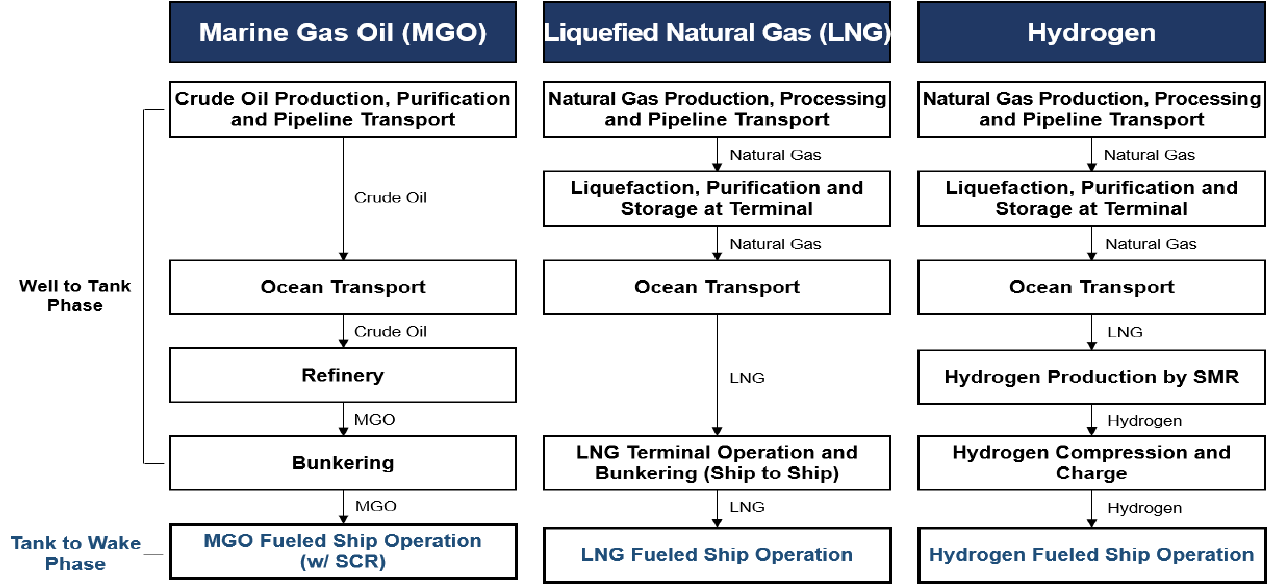
Figure 3. Inventory analysis range of LCA for each of the alternative fuels for ships. MGO is considered as being produced and then transported via a crude oil carrier (Table 1) from oil-producing countries, i.e., Saudi Arabia, Kuwait, Iran, and others, taking into account the portion of crude oil import in ROK [31], which is shown in Figure 4a. The imported crude oil is converted to MGO in ROK through the refinery process, which was modeled as shown in Figure 5, considering the electric and steam energy input of 100.7